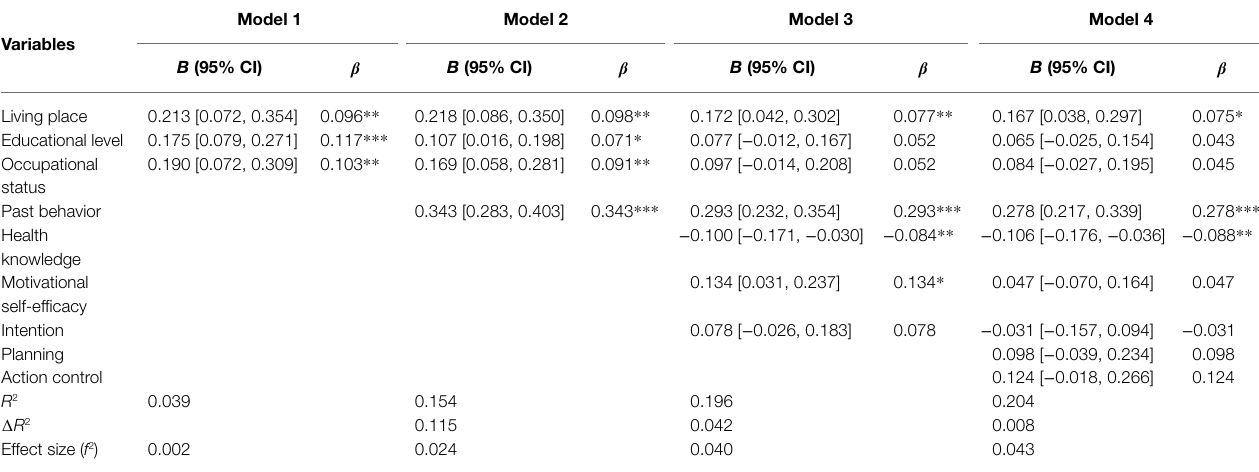
TABLE 6 | Hierarchical regression analysis with social distancing behavior ( N = 928).